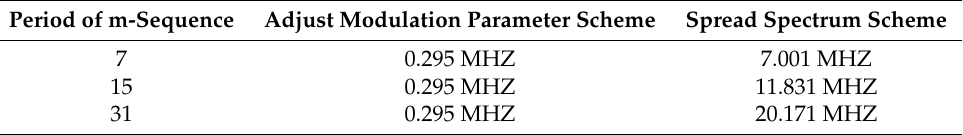
Table 3. − 40 dB Bandwidth of The Two Separated Multipath Schemes.